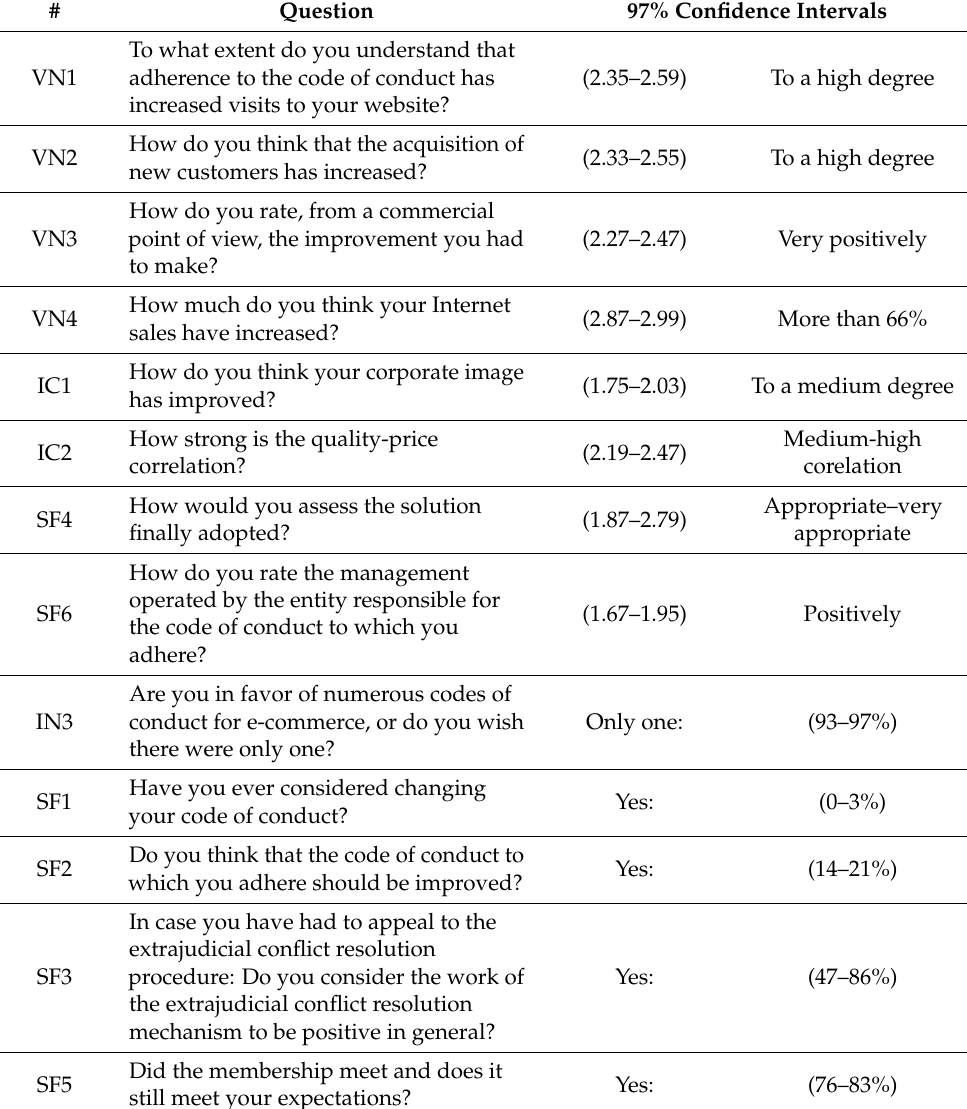
Table 7. Confidence intervals (ordinal qualitative and dichotomous